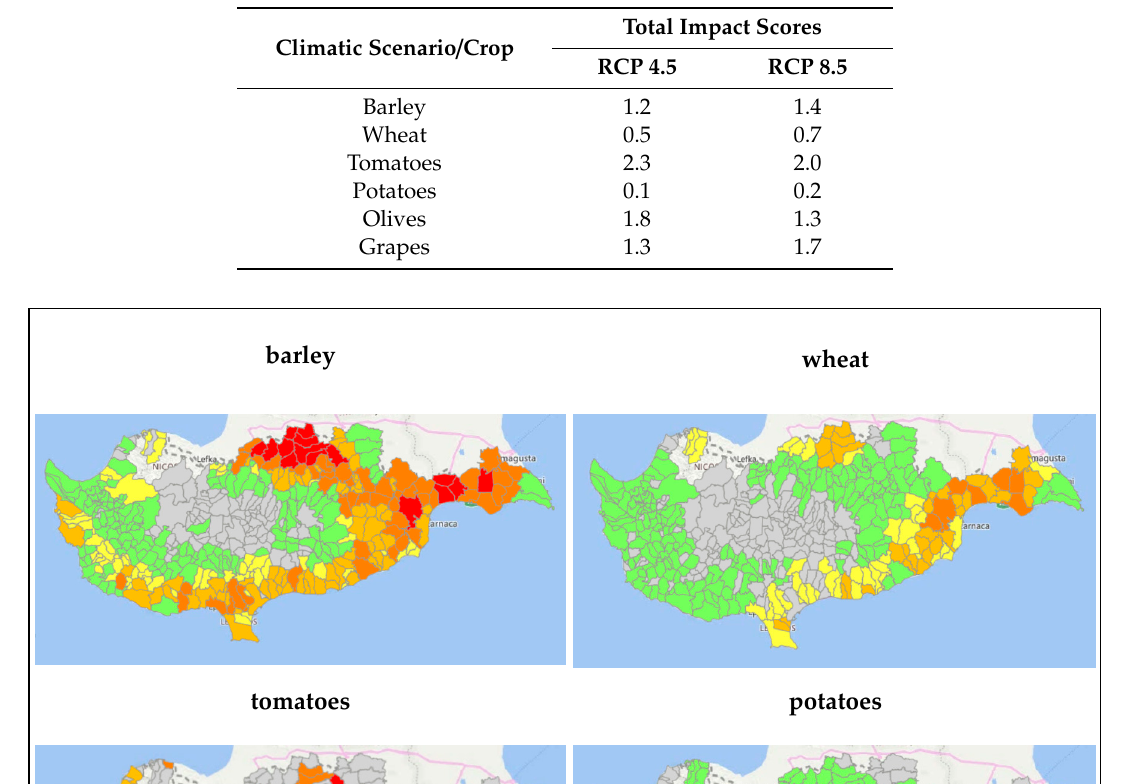
Table 12. Total climate change impact scores for the examined crops (cumulative normalized results).